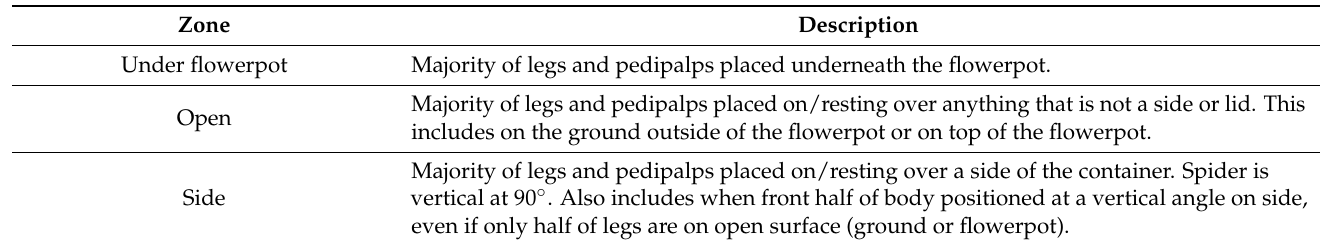
Table 2. Ethogram of key enclosure zones within captive female Brachypelma hamorii enclosures at ZSL London Zoo. Zone